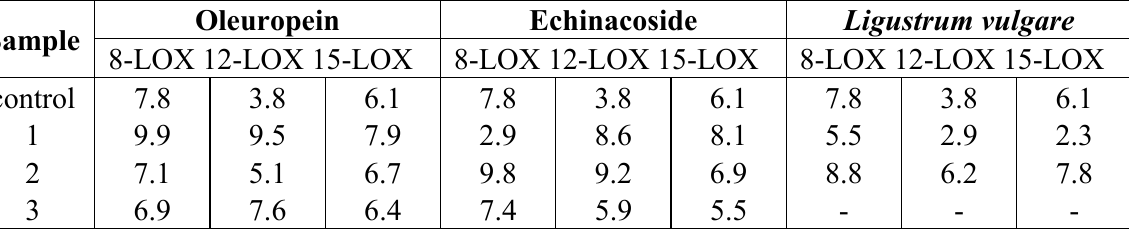
Table 3. SD values of measured antilipoxygenase activity for selected